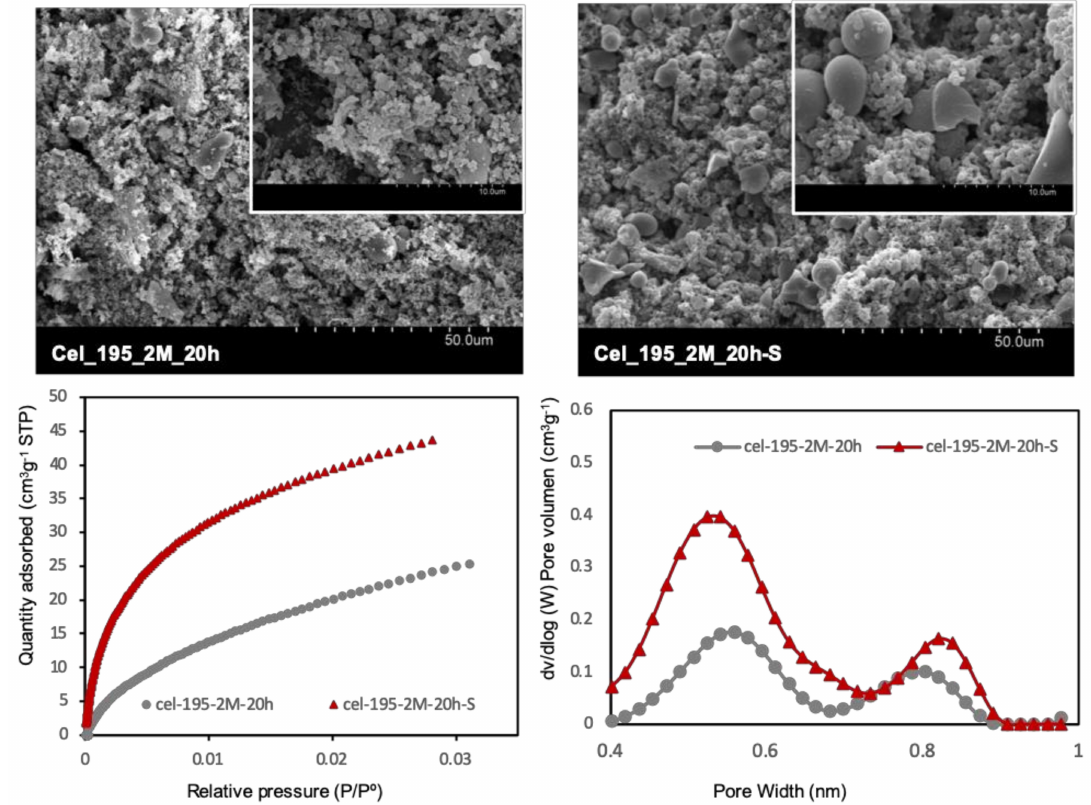
Figure 1. Comparison of textural properties of Cel-195-2 M-20 h (sample 3) and Cel-195-2 M-20 h-S (sample